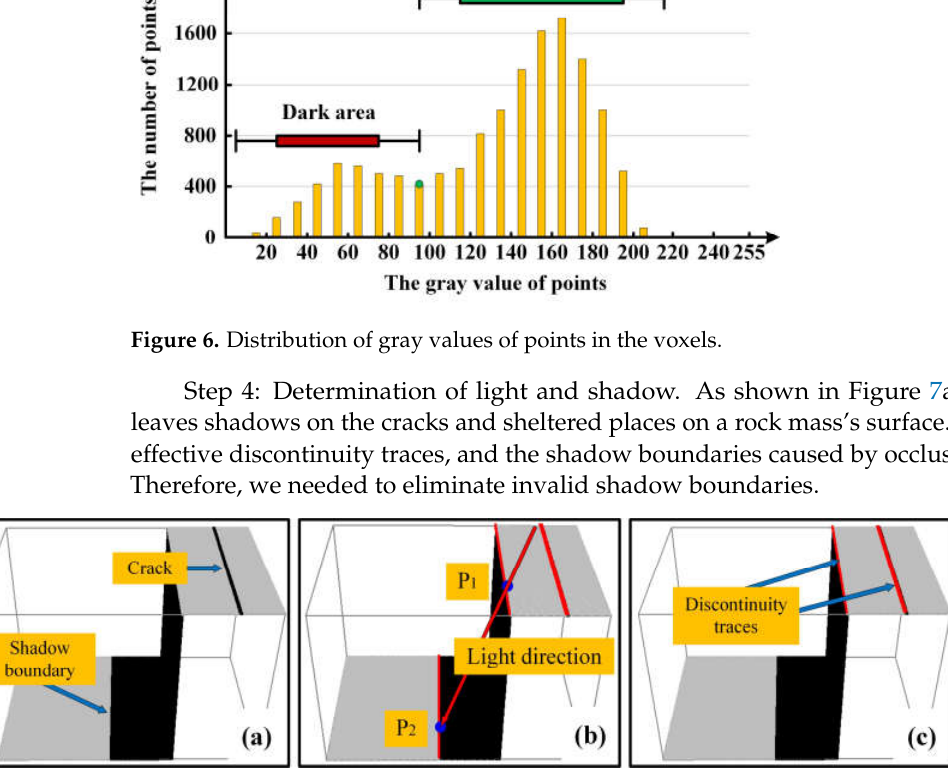
Figure 7. Determination of shadows. ( a ) Crack and shadow boundary; ( b ) determining the direction of the illumination; ( c ) effective discontinuity traces (the black area is a shadow area, P 1 and P 2 are shadow points). We considered different data collected at different places and different times. We